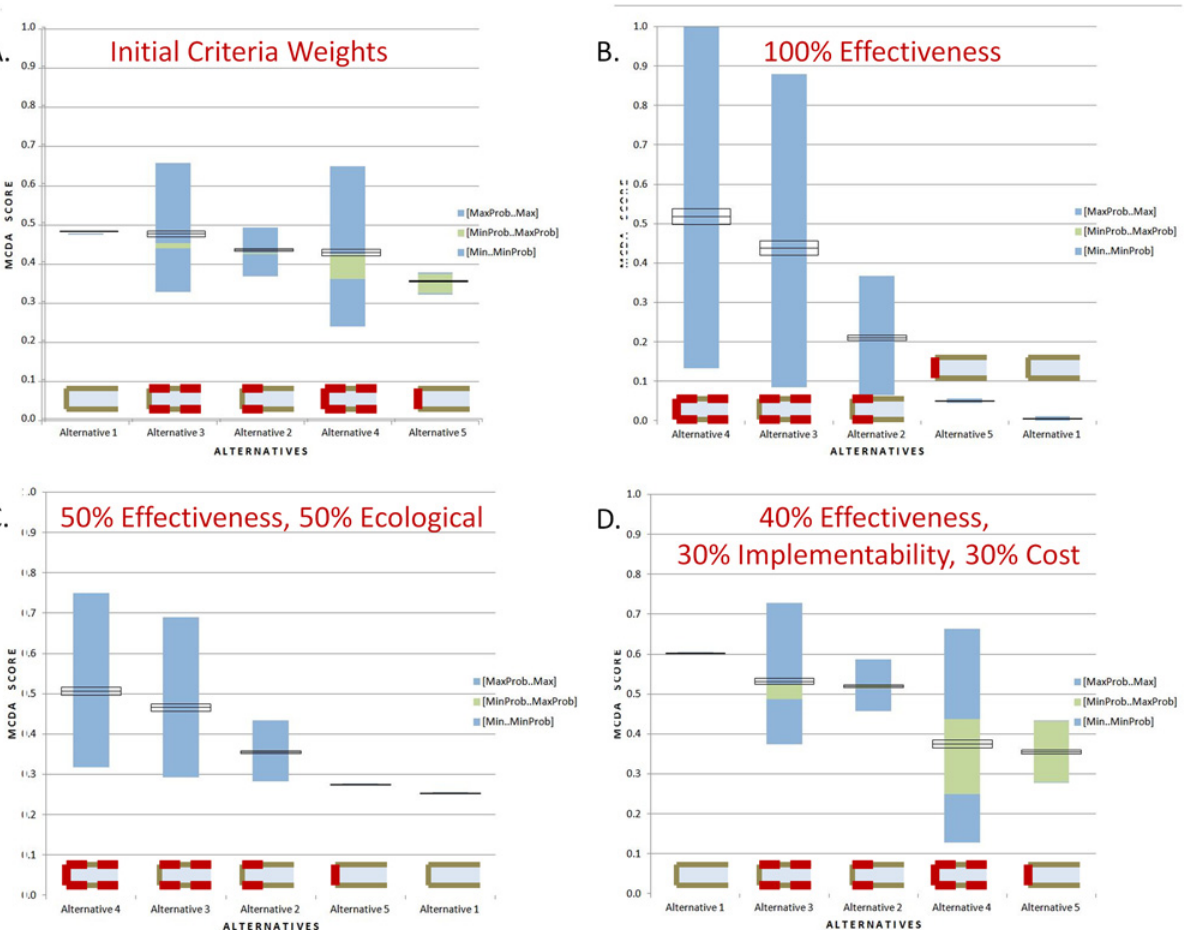
Figure 3. A basic sensitivity analysis of the effect of the criteria weights on the performance. The remedial alternatives are ranked according to their mean value score. For each alternative, black boxes indicate the mean and standard deviation of 1000 simulations across the range of probable values. The green box shows the highest and lowest possible scores achieved with the maximum and minimum probable values for that alternative, respectively. The blue boxes show the range of scores between the probable value and the possible value for each alternative; above the mean is the range of scores between the maximum probable and the maximum possible while the minimum range is below. (A.) The original weighting scheme of 40% effectiveness, 25% ecological effect, 25% implementability and 10% cost results in Alternatives 1 and 3 providing the highest. (B.) For this calculation, 100% of the criteria weight was placed on the effectiveness of the alternative in reduction in smallmouth bass MeHg concentration. The most aggressive alternative, Alternative 4 which includes both upstream sources control and extensive bank stabilization, has the highest mean value. (C.) For this calculation, 50% of the criteria weight was effectiveness and 50% was ecological effects. Again, Alternative 4 has the highest mean value, and the reduction in uncertain associated with the inclusion of ecological effect allows it to outperform Alternatives 4 and 5. (D.) The case with 40% of the criteria weight on effectiveness, 30% on implementability and 30% on cost also results in Alternatives 1 and 4 outperforming the other